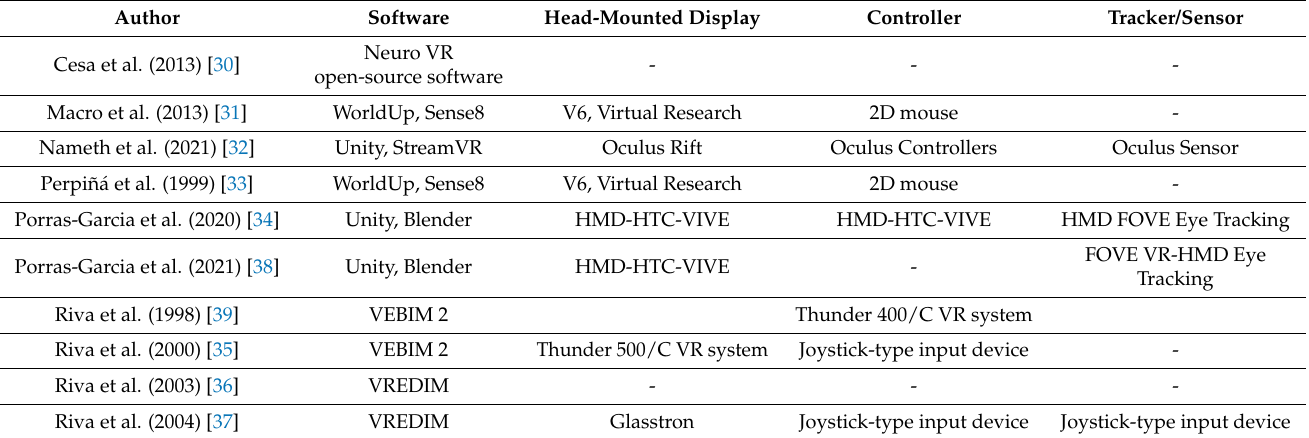
Table 3. Software and hardware for the implementation of VR in the reviewed articles.